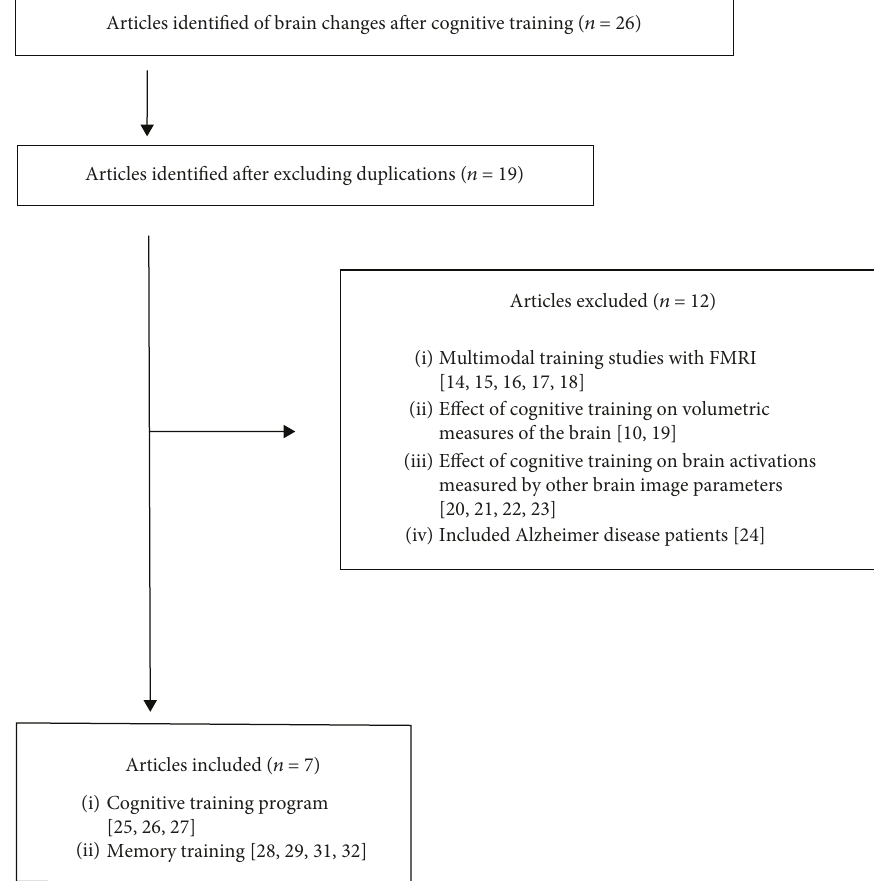
Figure 1: Summary of the studies identi fi ed and included in the